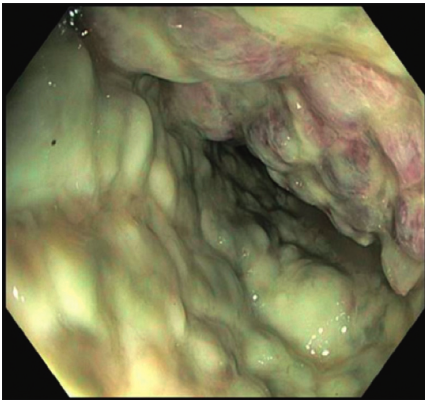
Figure 3: Midsigmoid colon showing extension of the severe colitis to the midsigmoid